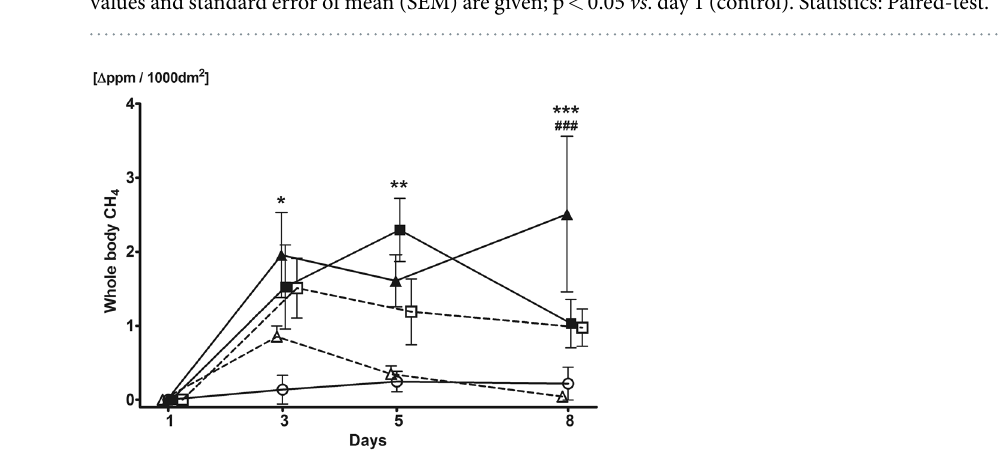
Mitochondrial function in the rat liver and hippocampus. The oxidative phosphorlylation capacity of METC in liver and brain homogenates was analyzed with high-resolution respirometry with saturating succinate and ADP concentrations (see Figs 4 and 5).